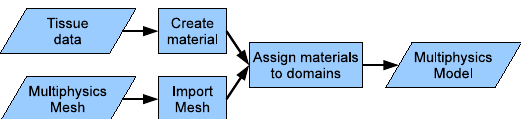
Fig. 19: Overview of modeling process. The inputs are tissue data and the previously generated mesh, which are being merged to create a model. This is the base for our bioimpedance experiment. This is done using